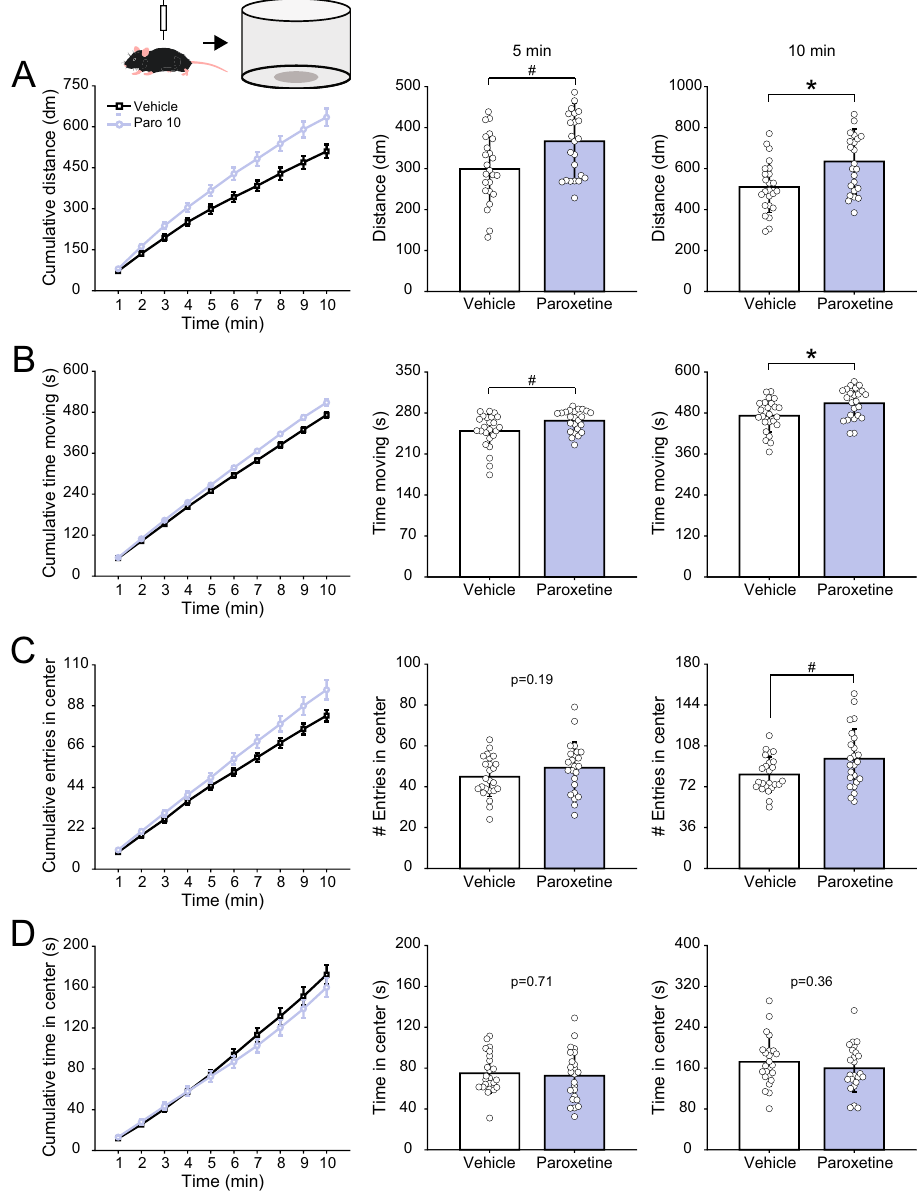
Figure 5. Paroxetine effects in the open field. ( A ) (Left) Cumulative distance moved in the open field. (Middle and right) Mean (± SD) distance after 5 (middle) and 10 min (right). White circles show data for individual animals. Animals were treated with vehicle or paroxetine (10 mg/kg) 1 h prior to behavioral testing. ( B – D ) As before, but for the time spent moving ( B ), number of entries in the center zone ( C ) and time spent there ( D ). Paroxetine increased locomotor activity and did not majorly influence the exploration of the center zone. # p < 0.05, *p < 0.01, two-sample